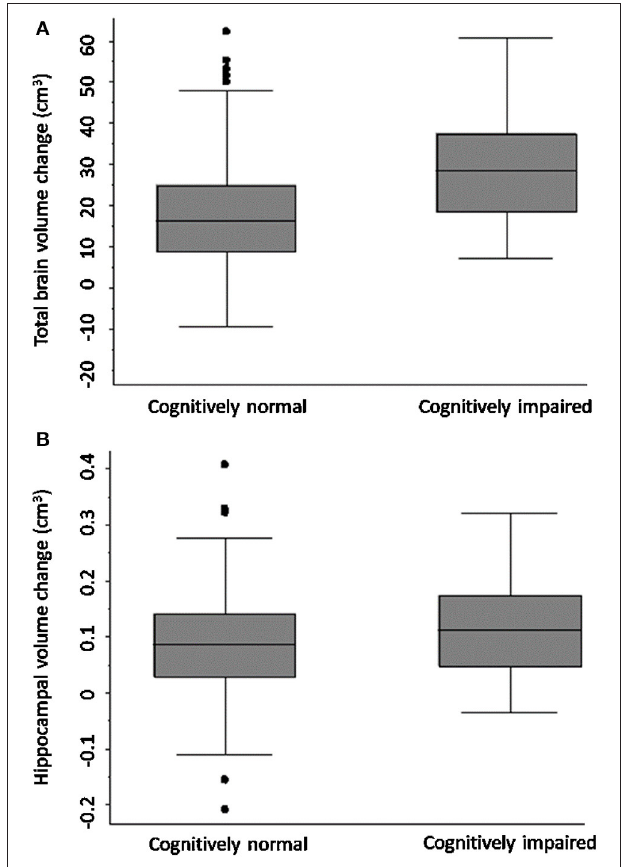
FIGURE 2 | Total brain and hippocampal volume change cognitively normal vs. impaired. Total brain volume (A) and hippocampal volume (B) change between 3-months and 3-years post-stroke in CN and CI stroke groups determined at 3-months. Y-axis = change in brain volume (cm 3 ). Positive values represent decline in brain volume, negative values represent an increase in brain volume. Midline = median brain volume